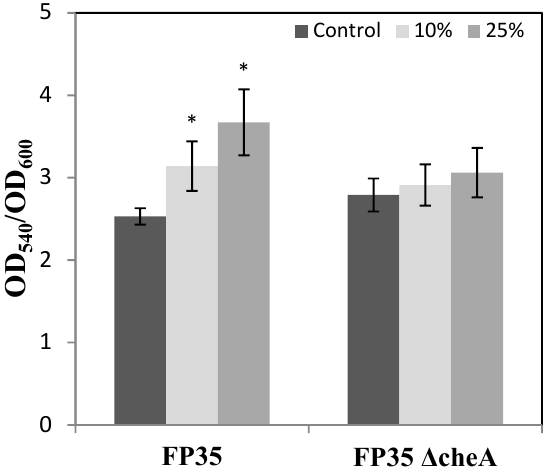
Figure 7. Biofilm formation of wild-type H. anticariensis strain FP35 T and the FP35 ∆ cheA mutant grown in 5% (w / v) sea salt solution induced by 10% and 25% (w / w) root exudate concentrations of Salicornia . The results represent the mean of three independent biological samples performed in quadruplicate, with error bars indicating standard deviations. Comparisons with respect to the control for each strain tested were made using the Tukey test (* p ≤ 0.05).